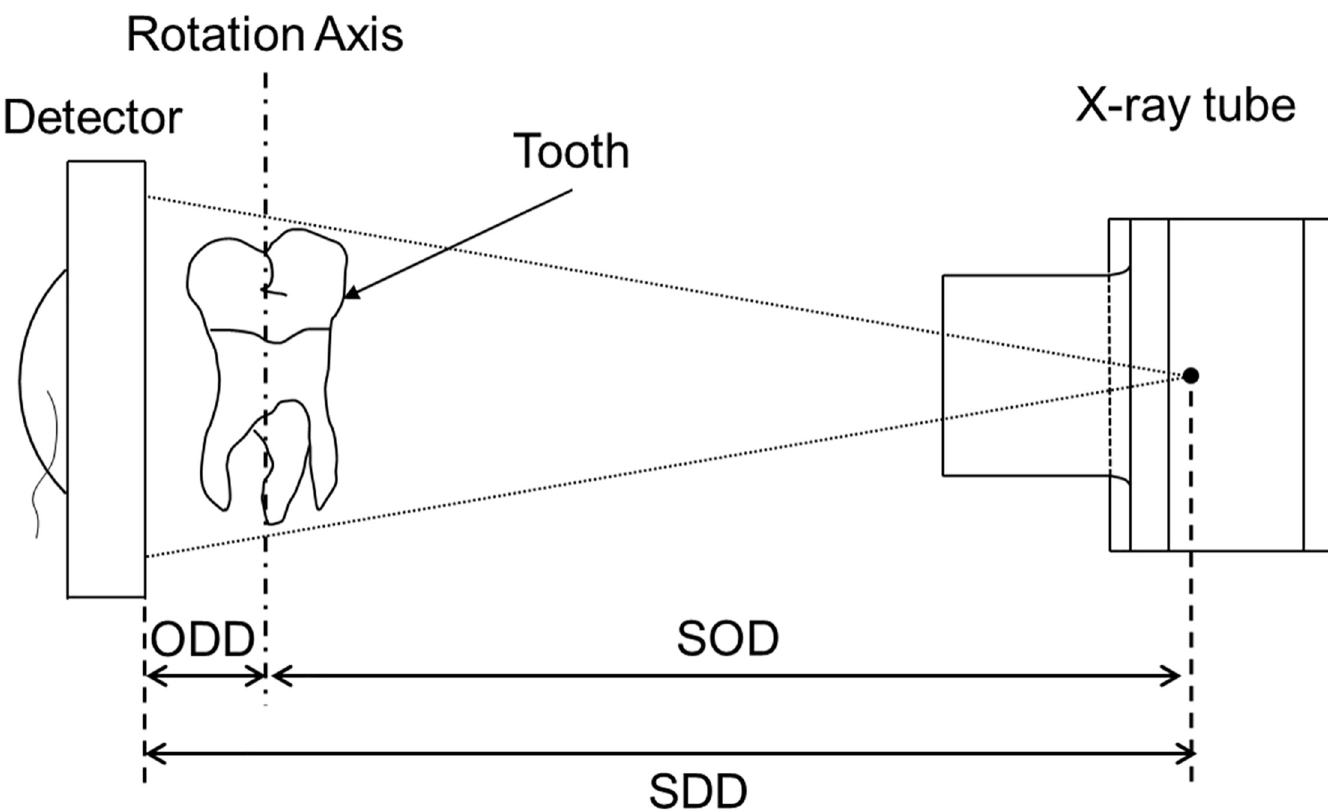
Fig 2. Geometry of the micro-CT system. The diagram shows the design used in the experiments. (SOD, source–object distance; ODD, object–detector distance; SDD, source–detector